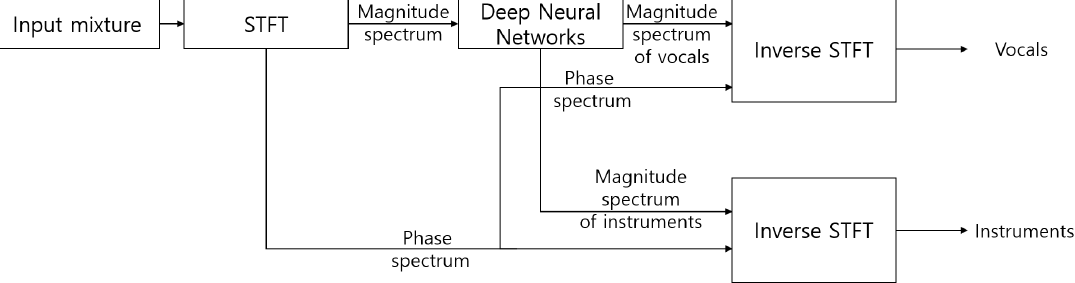
Figure 1. Illustration of a typical deep neural network framework for singing voice separation. The input and output features are the magnitude spectra of the short-time Fourier transform (STFT) of the time-domain signals. Neural network models are applied to separate vocal and instrument sources in the magnitude STFT domain, and the audio sounds are reconstructed by inverse STFT